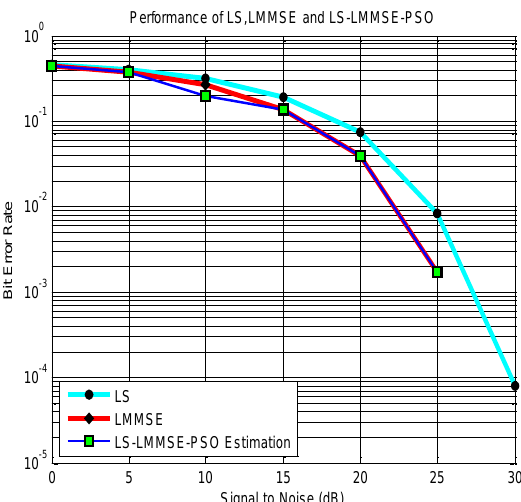
Figure 4: BER v/s SNR at Doppler frequency – 500 Hz